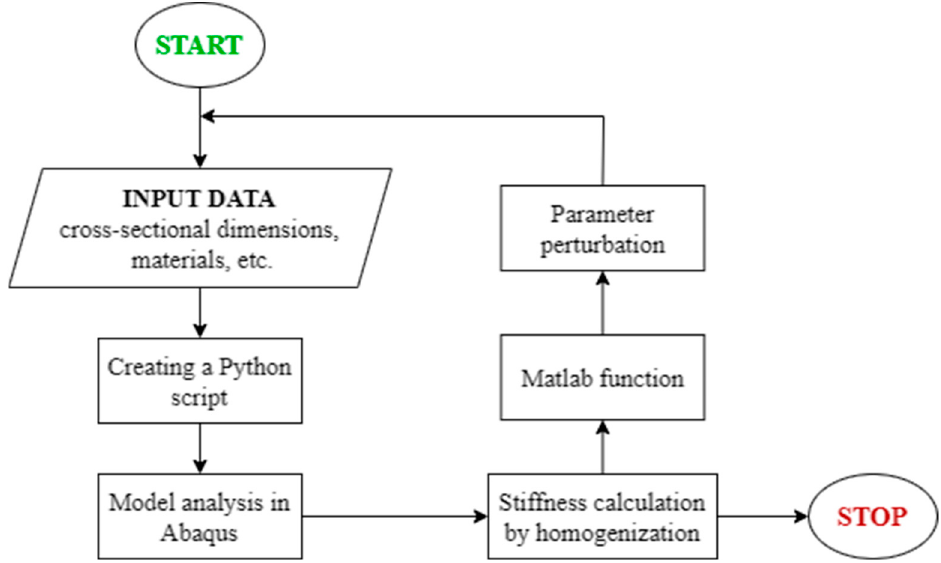
Figure 4. Flowchart of the algorithm for the analysis of sensitivity.